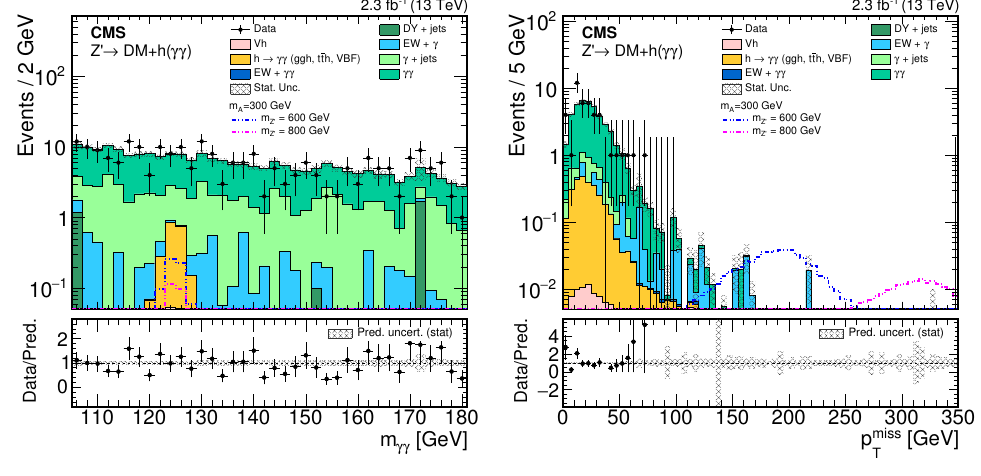
Figure 7 . Expected and observed distribution of m (cid:13)(cid:13) (left) in events passing all selection criteria except the m (cid:13)(cid:13) and p miss requirement. Expected and observed distribution of p miss T